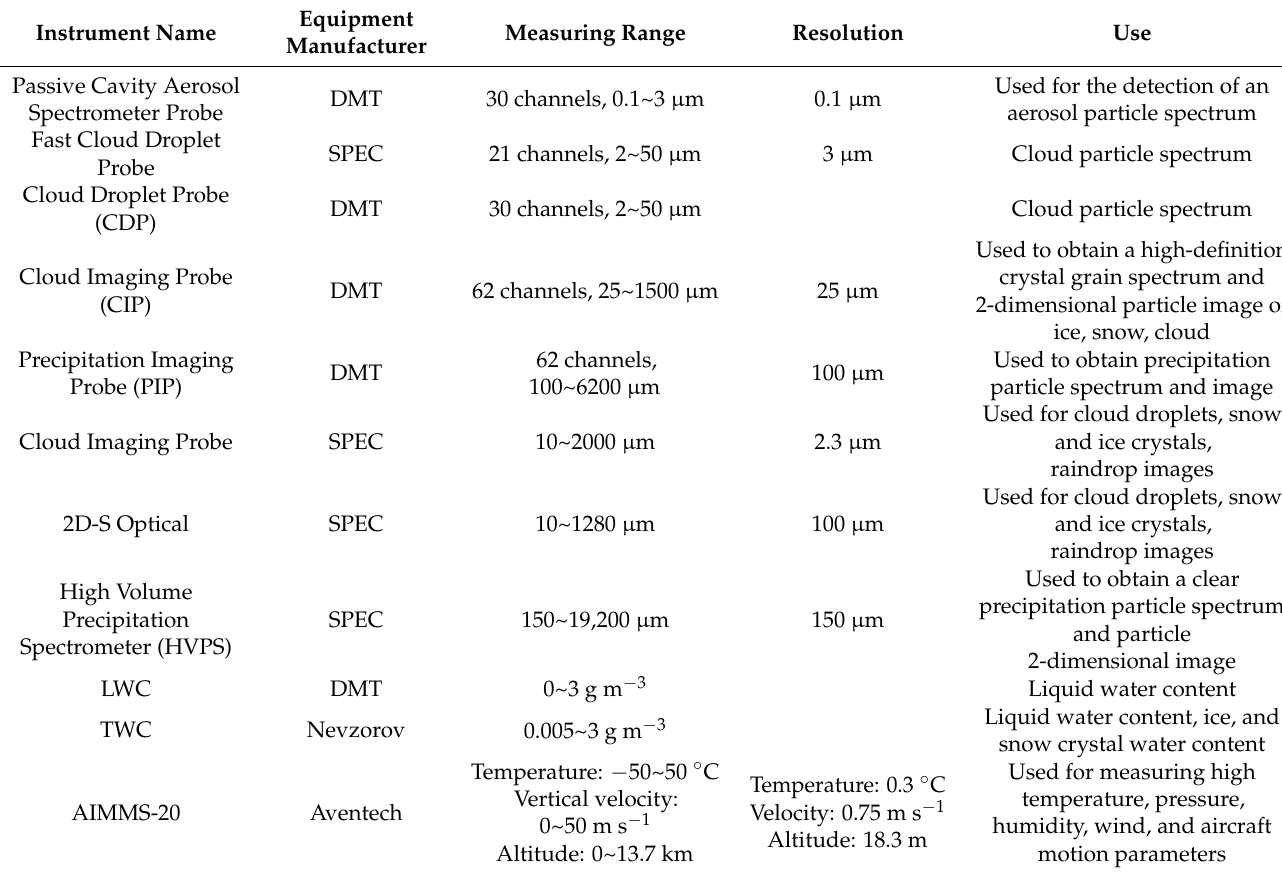
Table 2. Particle probe and its parameters. (Reprinted/adapted with permission from Ref. [5]. 2023, Jiefan